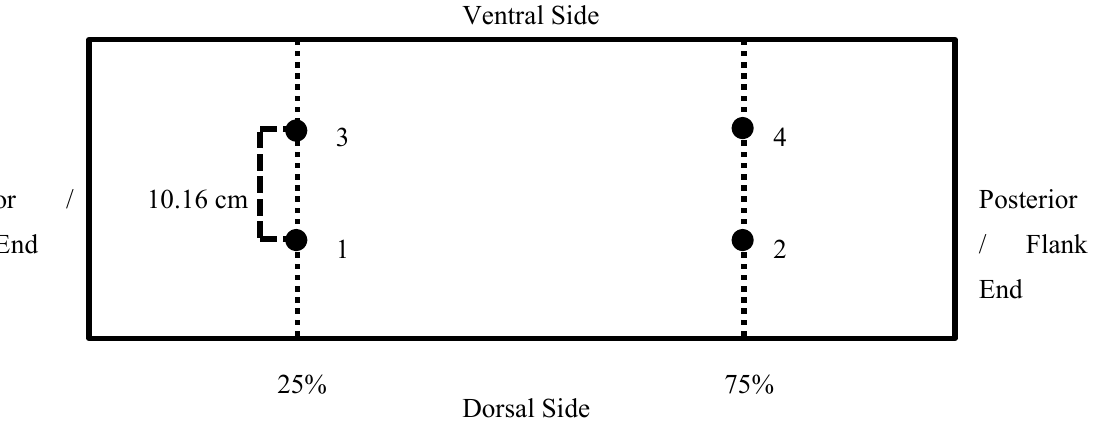
Figure 2. Diagram of belly thickness measured at four locations (1–4) at points 25 and 75% of the length from the anterior (blade) end, spaced 10.16 cm apart.